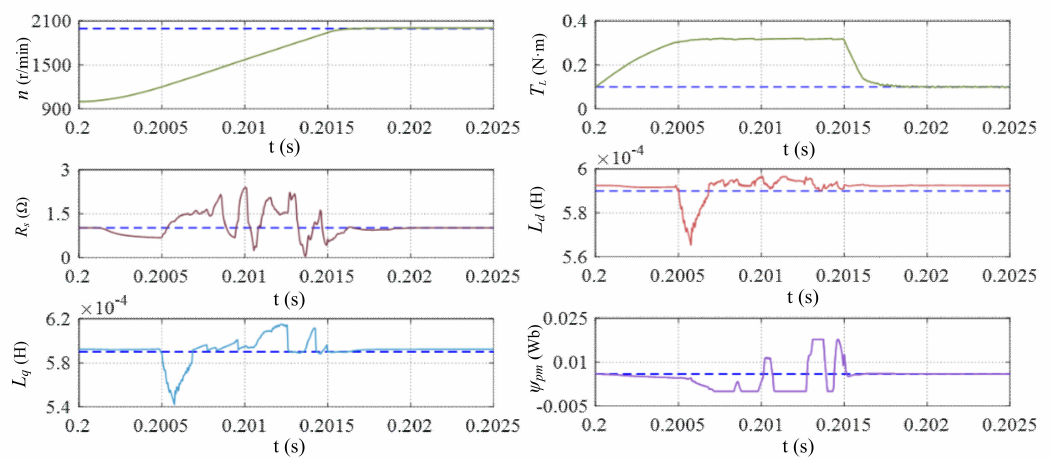
Figure 13. Parameter identification results when changes velocity.